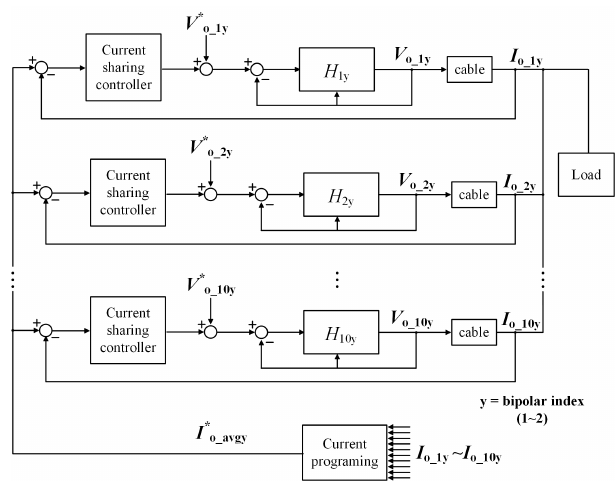
Figure 8. Control block diagram of current sharing